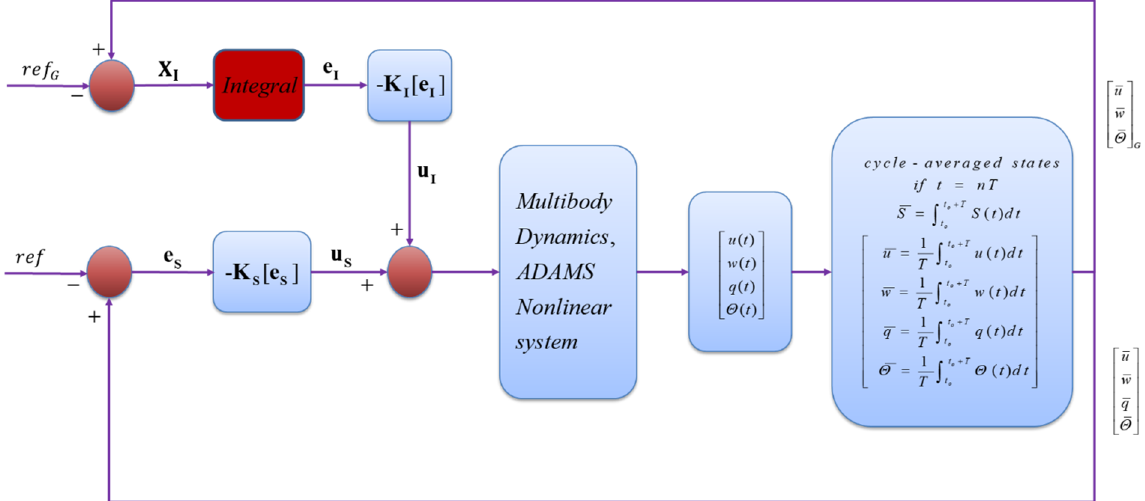
Figure 10. Schematic diagram of gain-scheduled LQR controller design for transition flight tracking of the nonlinear multibody model.